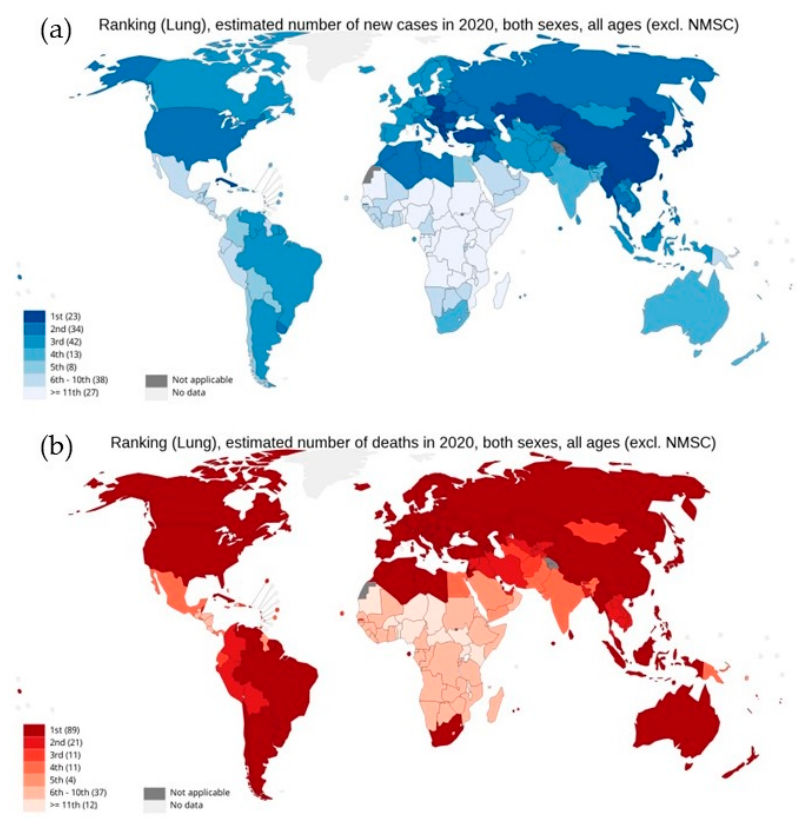
Figure 1. National ranking for lung cancer: ( a ) estimated new cases in 2020, ( b ) estimated number of deaths in 2020, in both sexes as per GLOBOCAN cancer statistics 2020. Graph production: IARC (http://gco.iarc.fr/ 18 August 2022), World Health Organization.